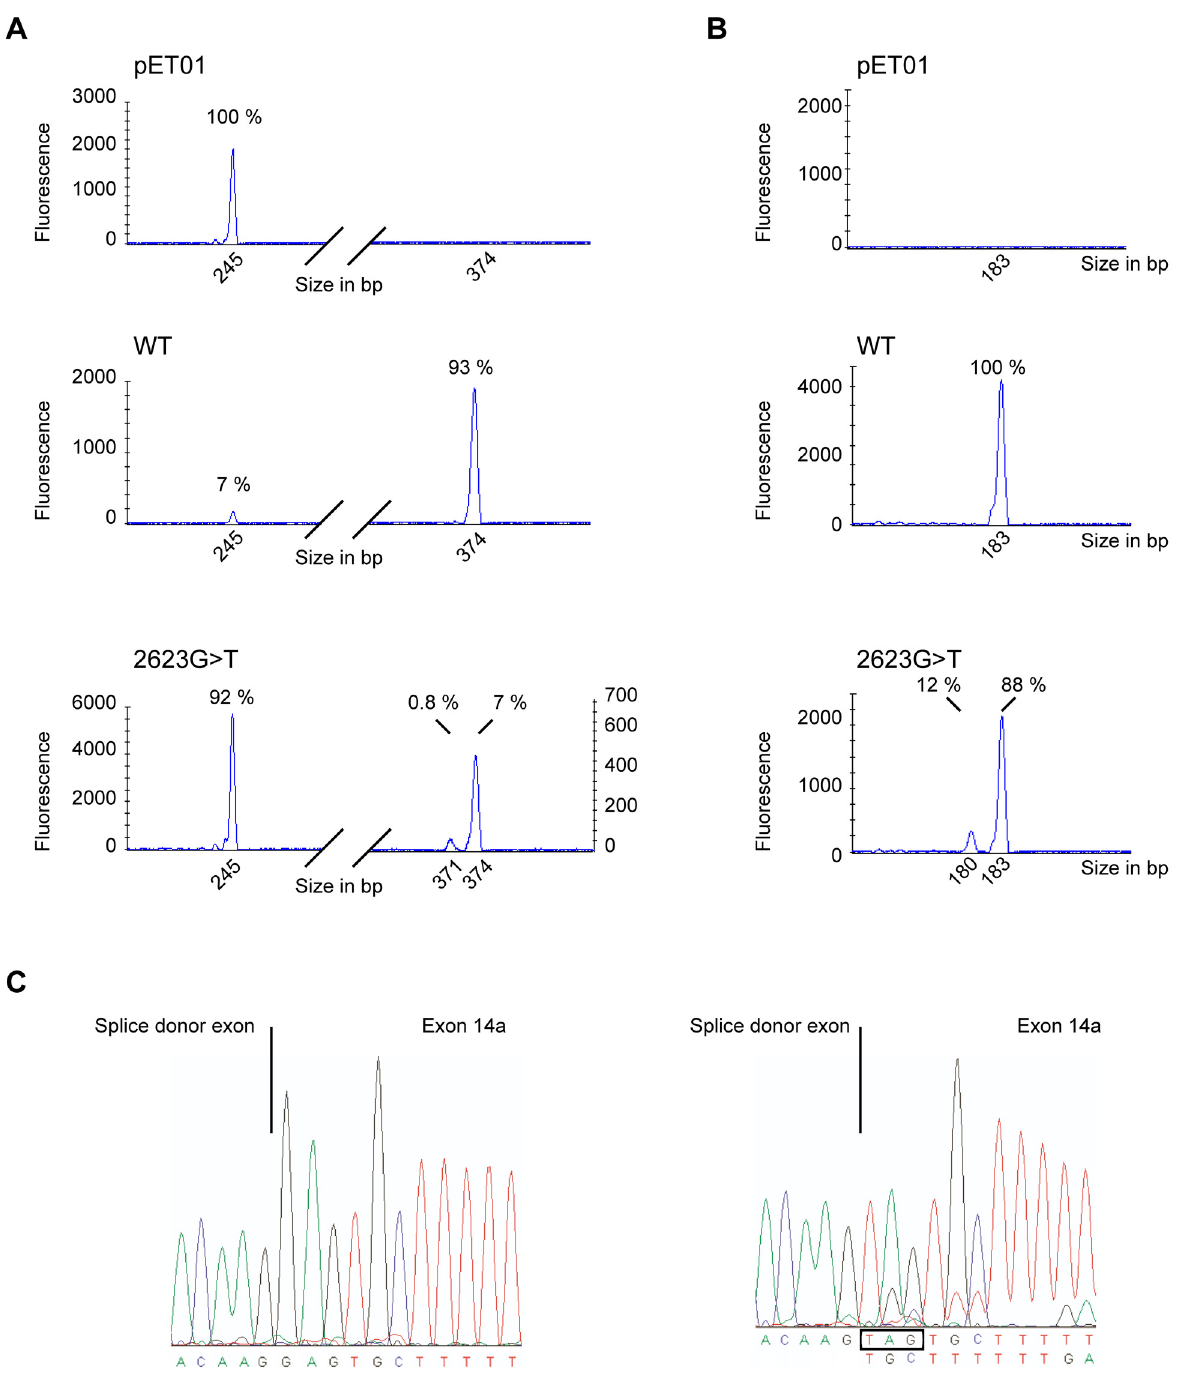
Figure 3. Hybrid minigene splicing assays. (A) Examples of capillary electrophoresis analysis of RT-PCR products obtained after 21 cycles. RNA was purified from BEAS-2B cells transfected with empty plasmid (pET01), minigene containing exon 14a (WT) or mutant exon 14a (2623G . T). RT-PCR was performed using a FAM-labeled forward primer located within the splice donor exon and a reverse primer within the splice acceptor exon of the pET01 plasmid. The corresponding size and relative amount of each peak is indicated. The peak at 245 bp corresponds to exon 14a skipped mRNA, at 374 bp to full-length mRNA and at 371 bp to mRNA lacking the UAG stop codon. (B) Examples of capillary electrophoresis analysis of RT-PCR products obtained with a FAM-labeled forward primer located within the splice donor exon of the pET01 plasmid and a reverse primer within exon 14a. The corresponding size and relative amount of each peak are indicated. The peak at 183 bp corresponds to full-length mRNA and at 180 bp to the mRNA lacking the UAG stop codon. (C) Sequences were obtained using unlabeled forward primer using the 21 cycle RT-PCR products from (B).